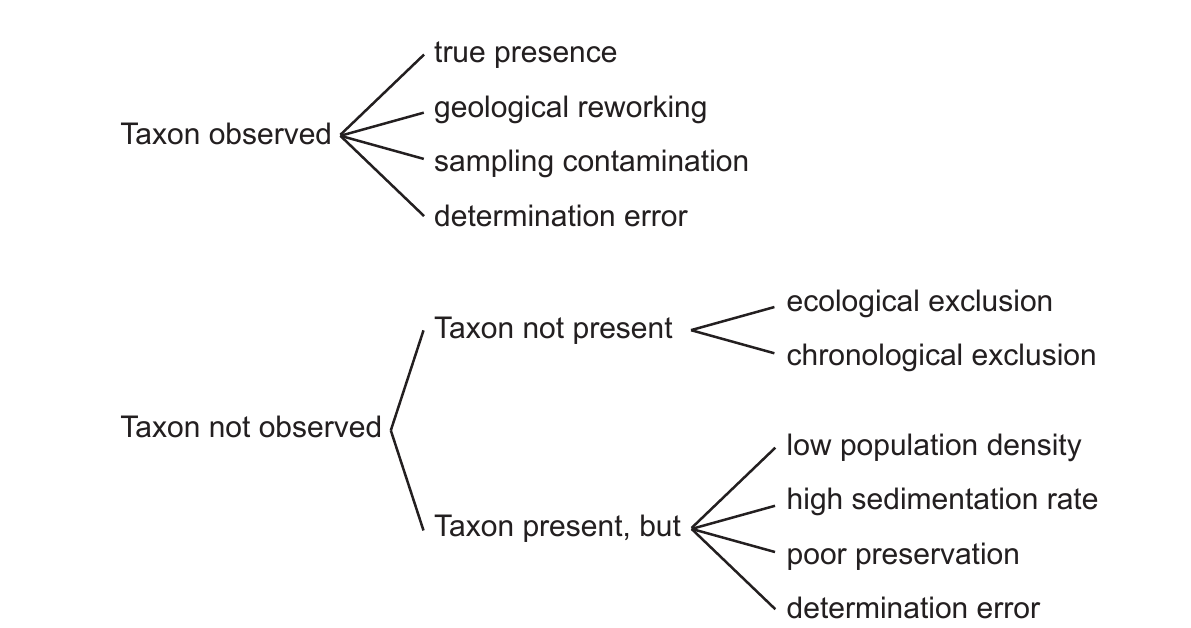
Figure 2. Sampling factors bearing on the quality of the paleontologic event record. With Jurassic planktonic foraminifera the state of preservation, either aragonitic (which is the original composition of the test) or calcitic plays a role, and so does the rate of sedimentation. For details, see